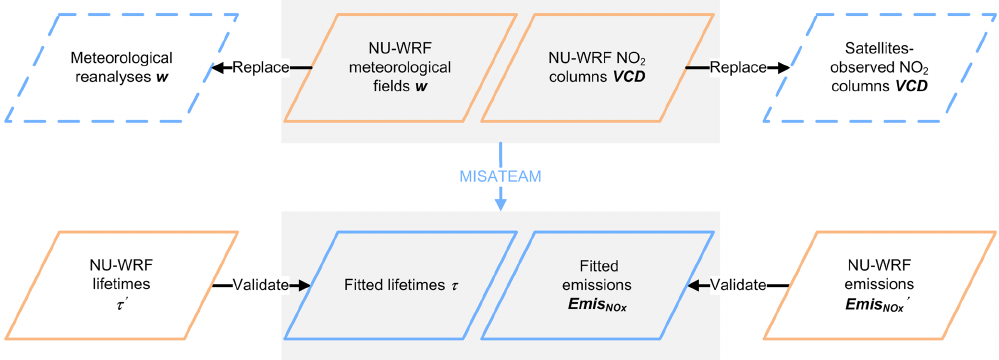
Figure 1. Schematic of our evaluation system to assess the accuracy of the inferring NO x lifetimes and emissions derived from MISATEAM. The blue symbols represent the inputs (dashed line) and outputs (solid line) of MISATEAM. The orange symbols represent the information derived from